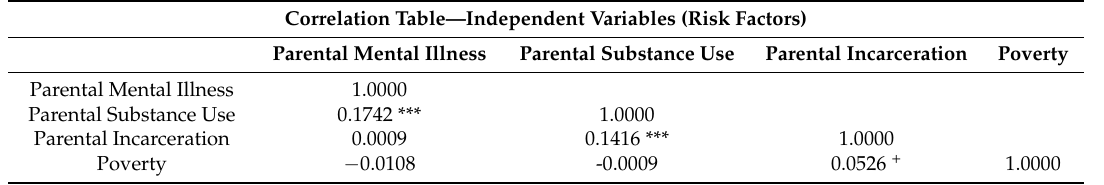
Table 3. Correlations among Independent Variables (Risk Factors). Correlation Table—Independent Variables (Risk